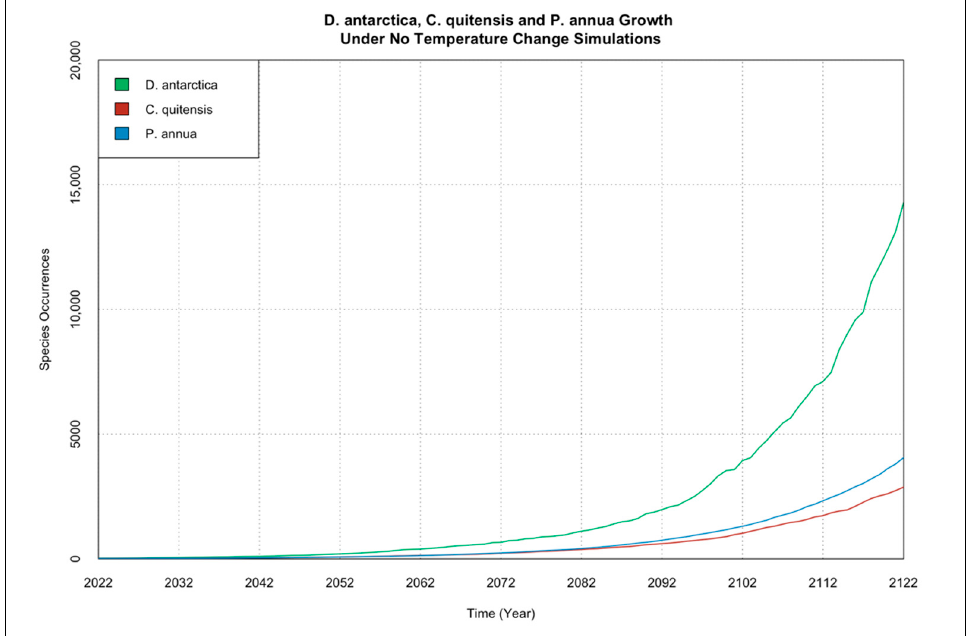
Figure 7. D. antarctica, C. quitensis and P. annua Occurrences under No Temperature Change Simulation.